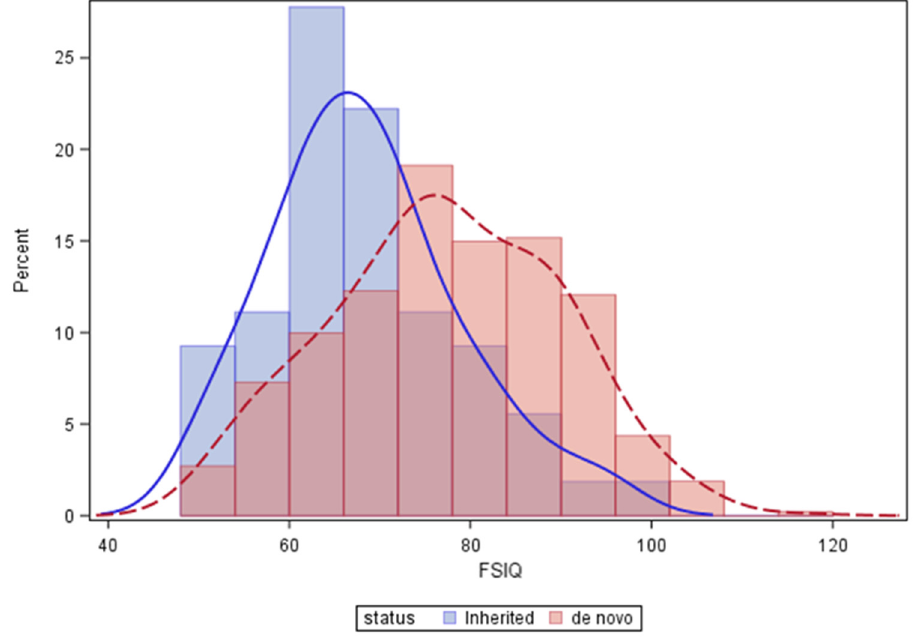
Figure 1. Major effect of the chromosome 22q11.2 deletion on IQ (from average 100), with further leftward shift for inherited 22q11.2 deletions compared with de novo 22q11.2 deletions. Table 1. Linear regressions to predict offspring FSIQ by parental 22q11.2 deletion status, sex, age at IQ testing and cohort